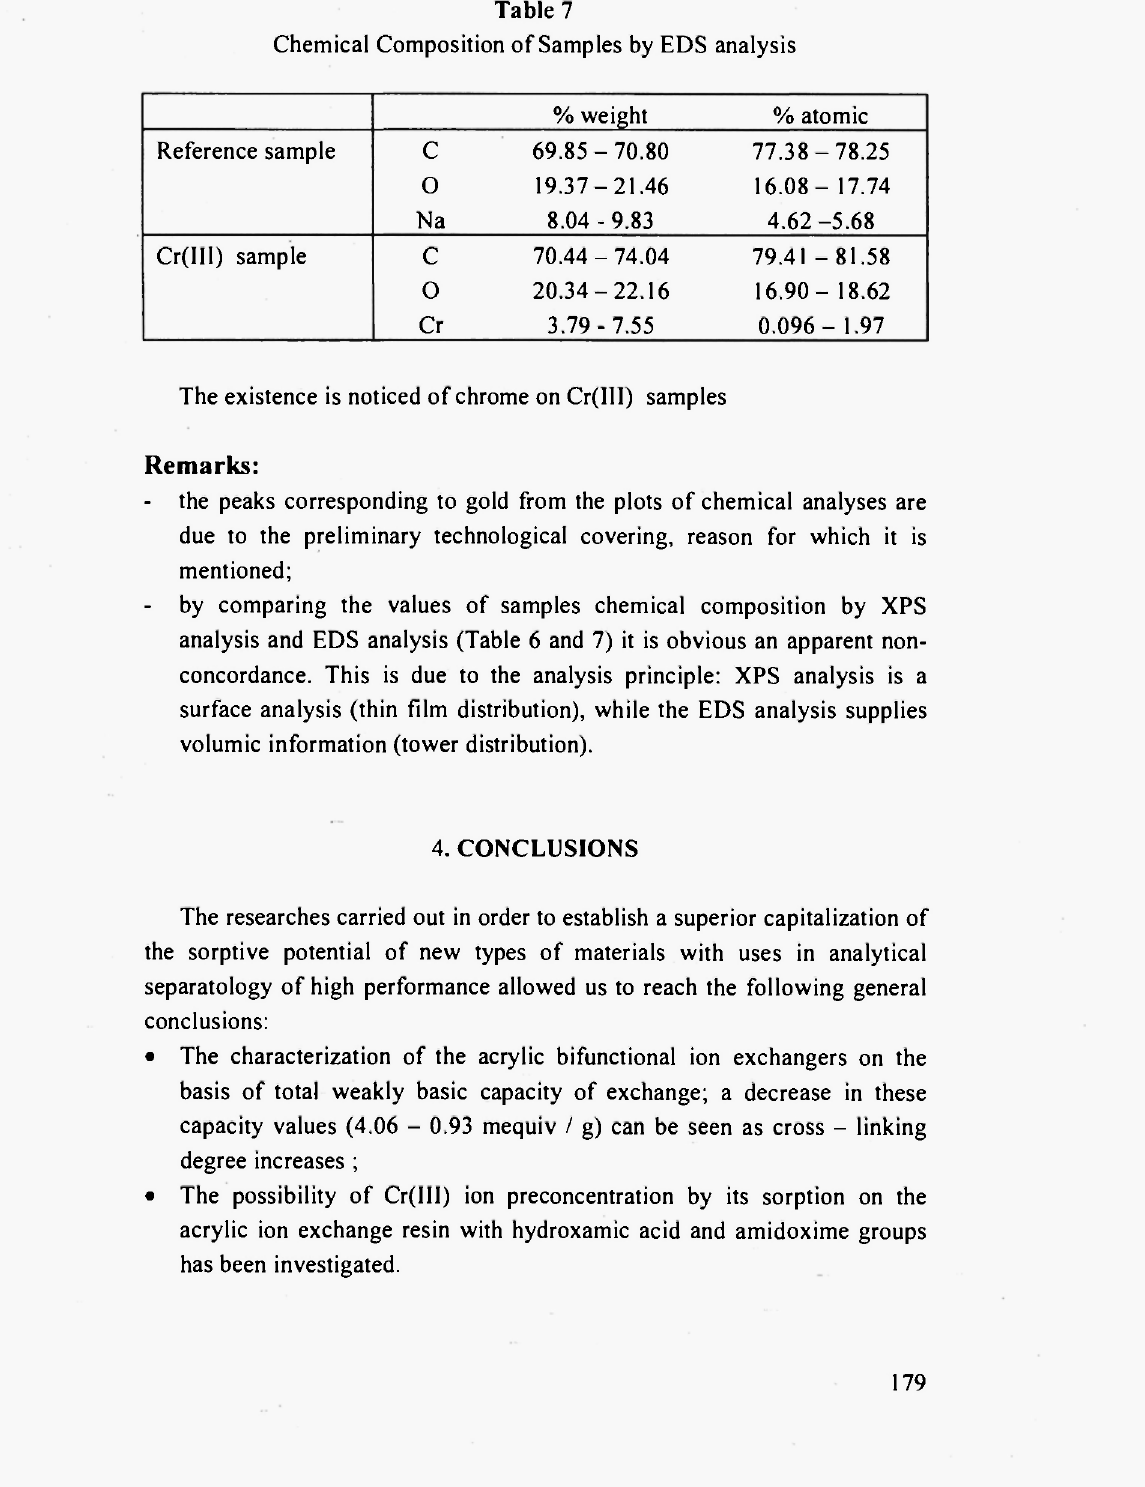
Chemical Composition of Samples by EDS